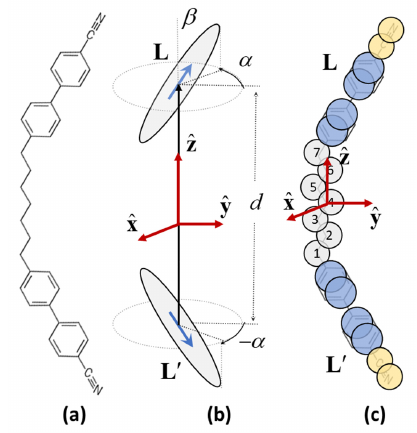
Figure 4. ( a ) Molecular structure of the CB- 7 -CB molecule in the all-trans conformation. ( b ) Molecular model used in the molecular theory of Section 3. The model mimics minimally the architecture of the mesogenic dimer in ( a ), particularly the bent-core structure and statistical a- chirality (equal weight for α and – α angles). ( c ) Spherical united atom representation of the mesogenic dimer in ( a ) as used in the molecular dynamics simulations of Section 4. The model is endowed with the full flexibility of the spacer chain, with conformations generated according to the Ryckaert–Bellemans torsional potential and segmental interactions parameterized as in [39]. The rigid segments L and L’ in ( b , c ) denote the mesogenic units of the dimer molecule. Finally, the effective potential is obtained by applying the mean field approximation. Despite the extreme simplicity of the molecular modeling and of the statistical mechanical treatment, the resulting effective potential ω ( ; ) V Z has a rich content as it includes D terms promoting the polar ordering (although the interaction among the mesogenic units is strictly apolar) and also the roto-translational modulation of the respective polar director on moving along the Z -axis. This is a consequence of a key feature of the otherwise quite primitive molecular modeling: the molecules consist of two individually interacting units separated by a finite (non-vanishing and bounded) distance d and maintaining a (“bent-core”) configuration that confers to the overall molecule significant deviation from linearity. The crucial contribution to the effective potential comes from a term [16] of the form